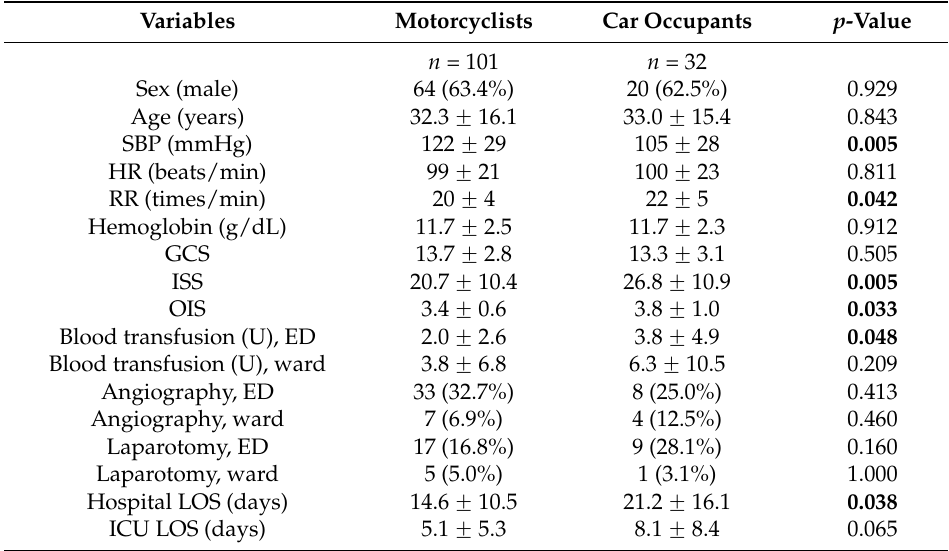
Table 1. Characteristics and management of high-grade BHSI in motorcyclists and car occupants. Variables Motorcyclists Car